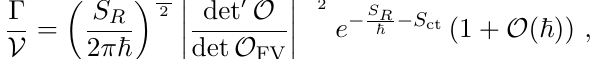
The argument of the exponent in (2.2) is dimensionless and has two parts. The first